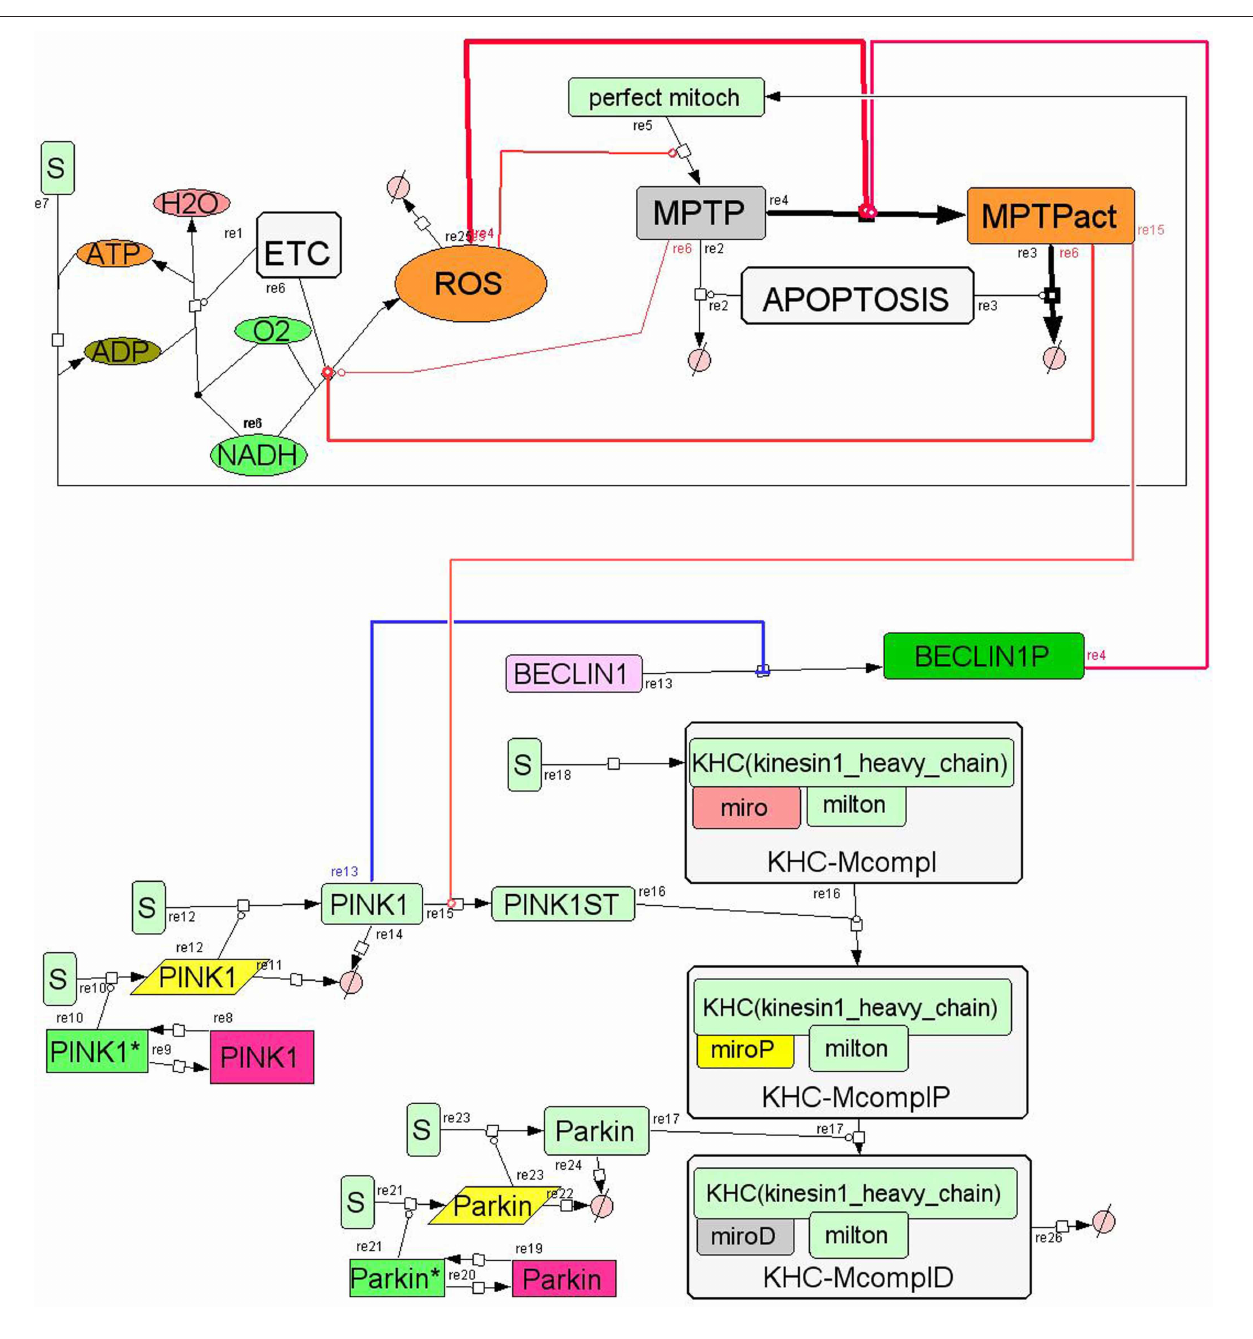
FIGURE 1 | Proposed core mechanism for modeling of growth and apoptosis of mitochondria. The basic assumption is that mitochondria can be in one of three different states: normal mitochondria, damaged mitochondria with non-active mitochondrial permeability transition pore (MPTP), and damaged mitochondria with active MPTP (called MPTPact on the diagram). Activation of the MPTP increases apoptosis of mitochondria